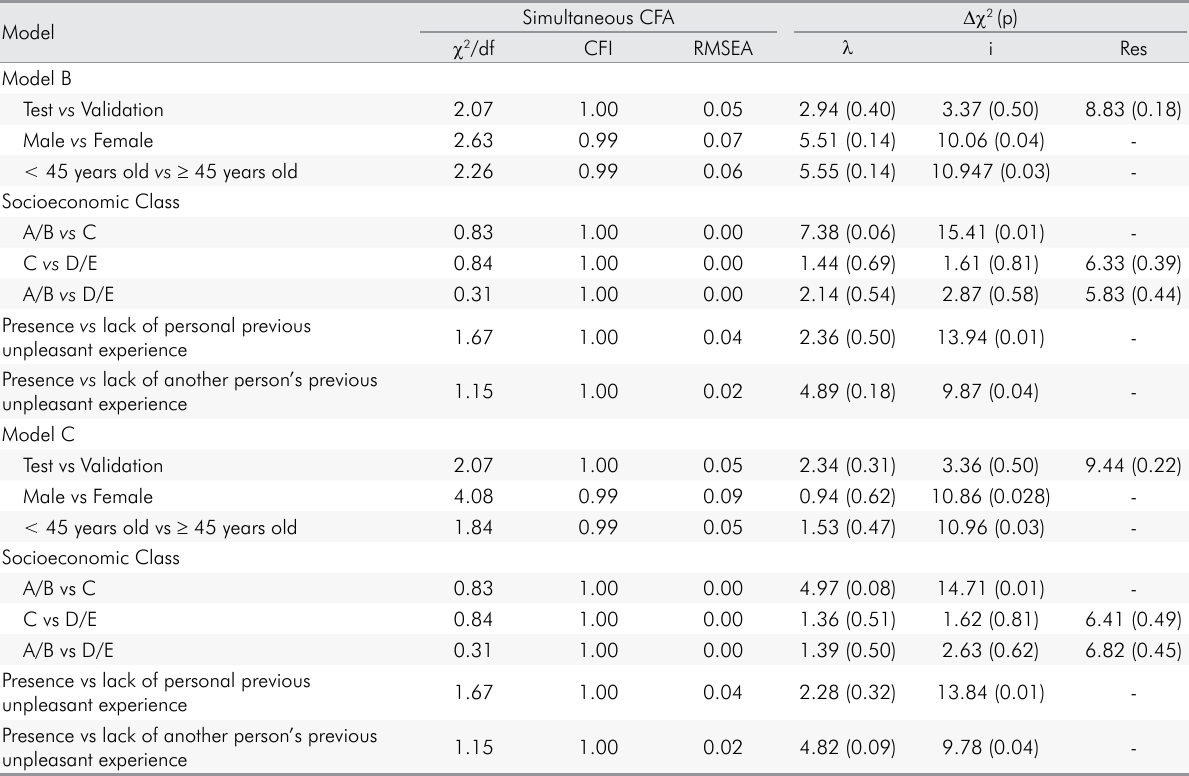
Table 3. Multigroup analysis to determine the invariance of the models across different subsamples.